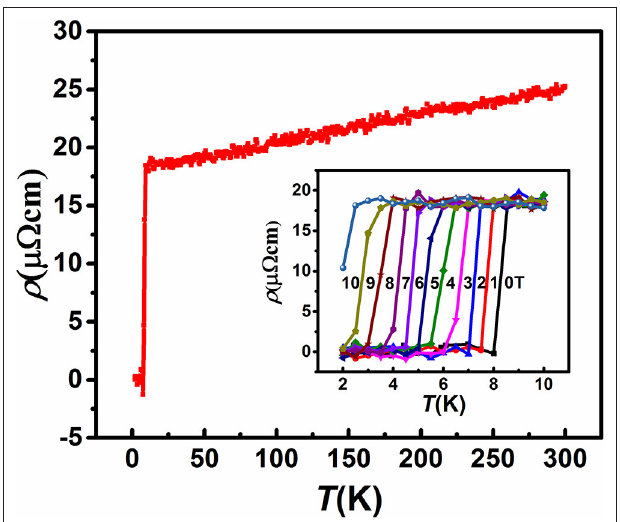
FIGURE 4 | Temperature dependence of magnetic susceptibility χ ( T ) measured under zero-field-cooled (ZFC) and field-cooled (FC) conditions at 3 mT for Ti 15 Zr 15 Nb 35 Ta 35 samples. The left inset shows isothermal magnetization M ( H ) curves for Ti 15 Zr 15 Nb 35 Ta 35 HEA at 3-10K in the field range up to 80 kA/m. The lower right inset is the temperature dependence of the lower critical field H c 1 ( T ).